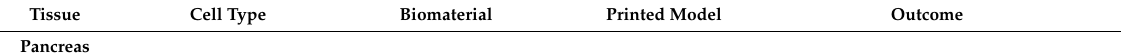
Table 3. Remarkable achievements in 3D bioprinting of pancreatic